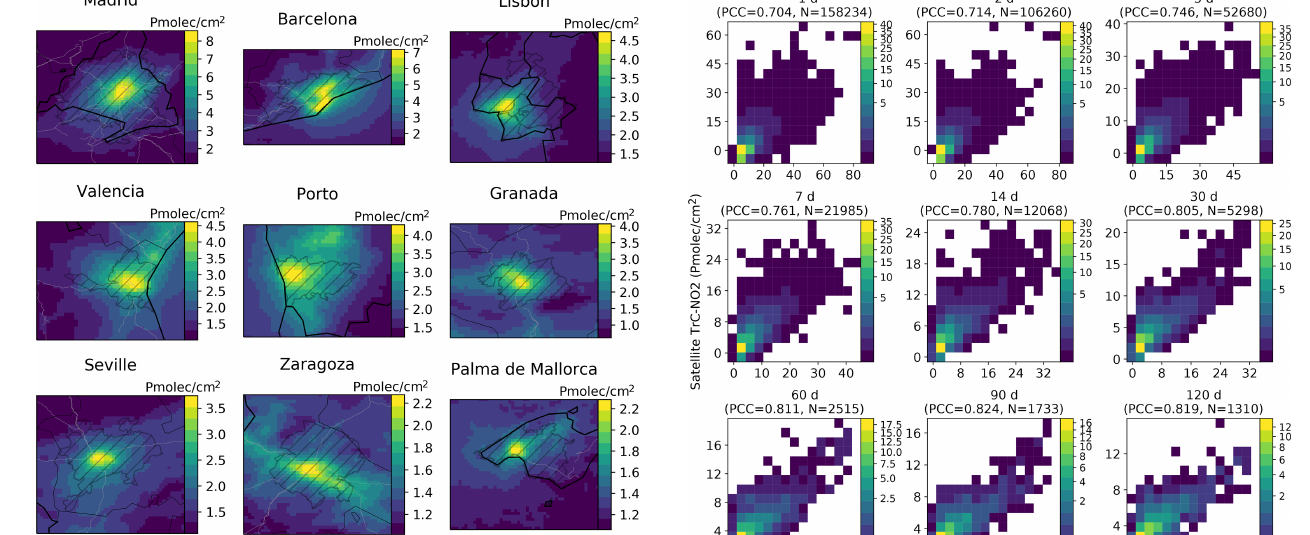
Figure 3. Mean TROPOMI TrC-NO 2 over main Iberian Penin- sula cities (on average from May 2018 to December 2021). Black lines, grey lines and hatched areas correspond to administrative bor- ders, Spanish major roads and functional urban areas, respectively (sources: see Sect. 2.4). Pixels are shown at their 0 . 025 ◦ × 0 . 025 ◦ resolution.